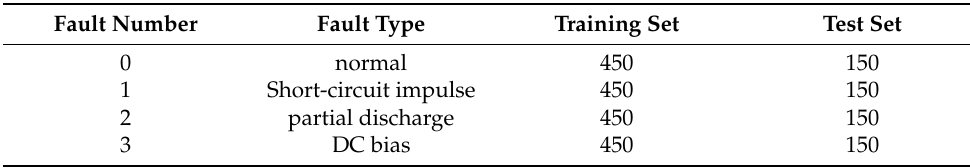
Table 2. Classification of experimental datasets.